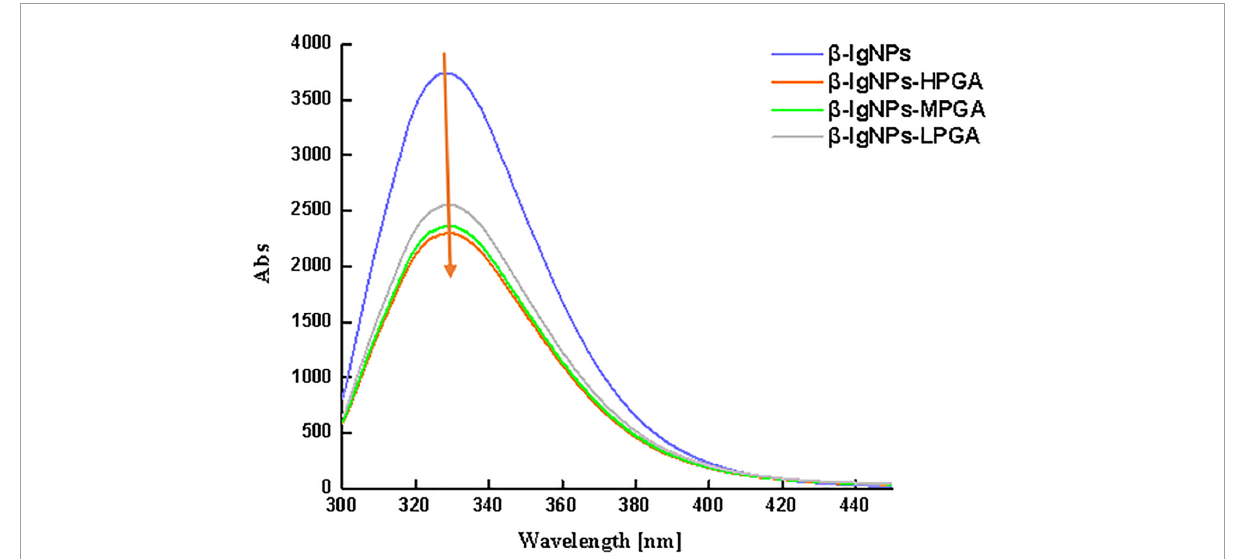
FIGURE5 The fluorescence spectroscopy of β -lgNPs and PGA- β -lgNPs complexes with different PGA M